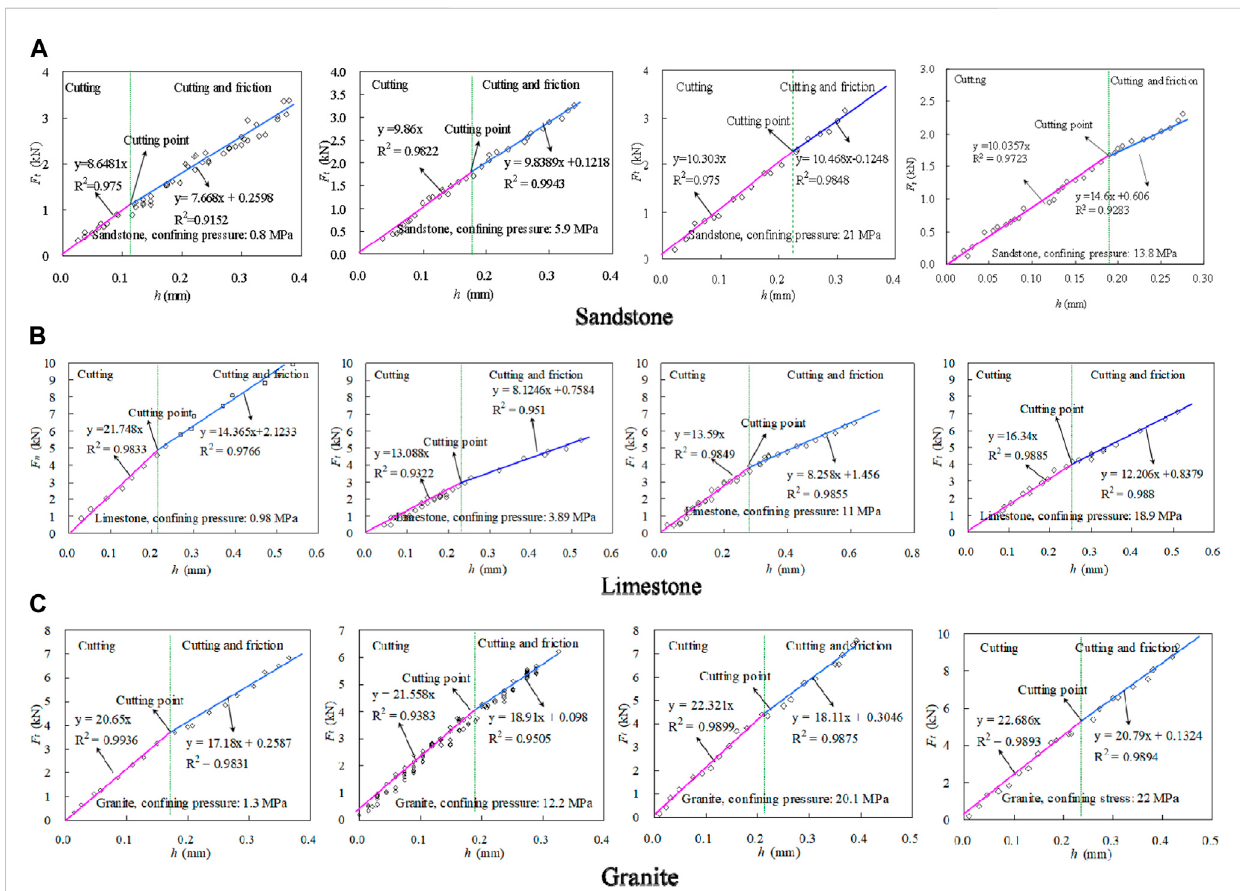
FIGURE 5 Plotoftorqueforceasafunctionofpenetrationdepthperrotationatfourdifferentcon fi ningstresses. (A) Sandstone, (B) Limestone,and (C) Granite.